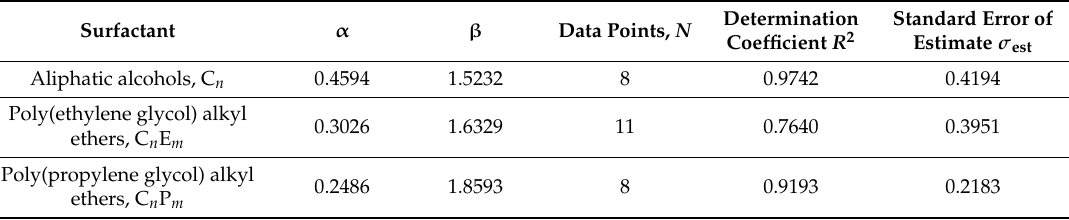
Figure 13. Relationship between lnCMH and lnCCC 95 for tested nonionic surfactants. Solids represent the experimental point (data: CMV Table 1, CCC [18,28]), while lines represent linear fitting curves. Table 3. Constants in linear trends in the relationship between lnCMV and lnCCC (Figure 13, lnCMV = α lnCCC − β ) that depend on frother family and goodness-of-fit statistics.